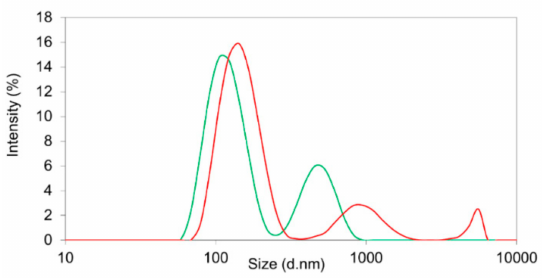
Figure 3. Size distribution by intensity of nanocomposites containing sorafenib in Resomer ® RG 502H (green line) and Resomer ® RGP d5055 (red line) matrix nanoparticles prepared by nanoprecipitation, using PVA as an emulsifier.